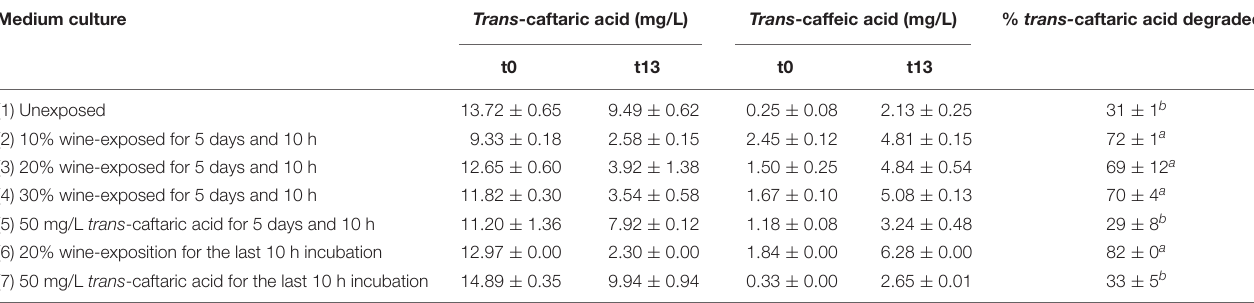
TABLE 6 | Cinnamoyl esterase activity in cultures of O. oeni OenosTM previously grown in different culture media, in KH 2 PO 4 buffer (0.15 M, pH 4.5, 9% EtOH) at 25 ◦ C supplemented with trans -caftaric acid. Medium